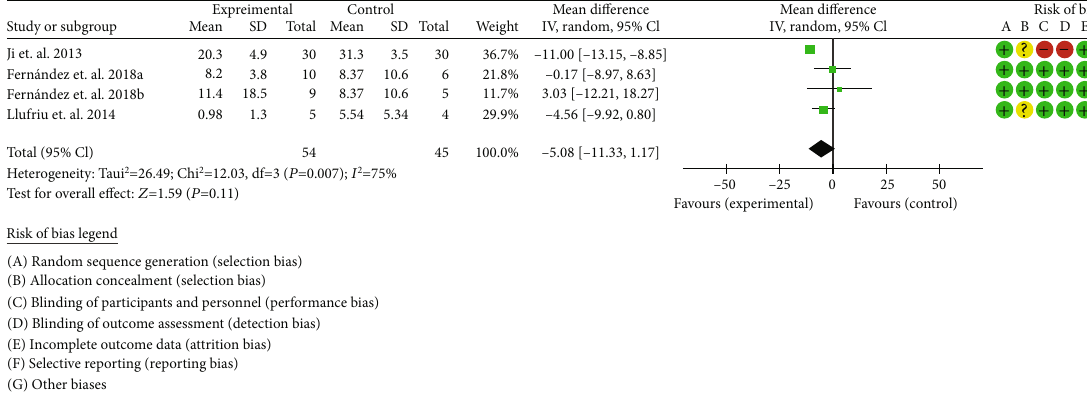
Figure 11: Volume of lesions (CI: con fi dence interval).